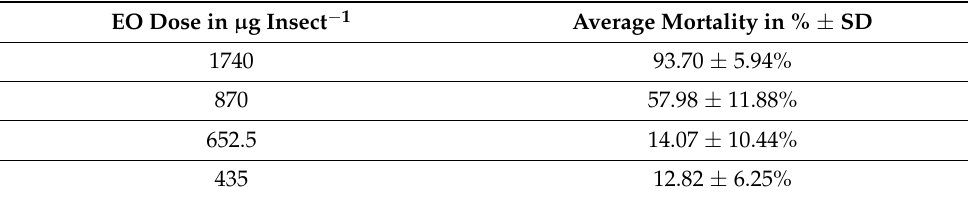
Table 6. Average mortality (in % ± standard deviation) of yellow mealworm Tenebrio molitor larvae after 48 h exposure to juniper EO .